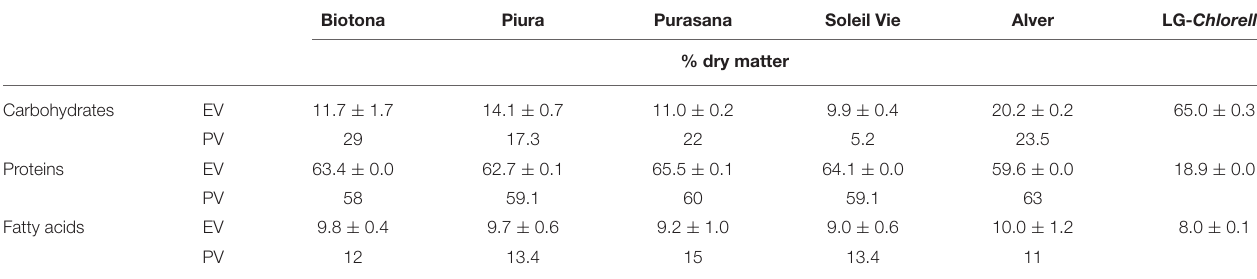
TABLE 2 | Macronutrient composition (% per 100 g DM) of dried microalgal